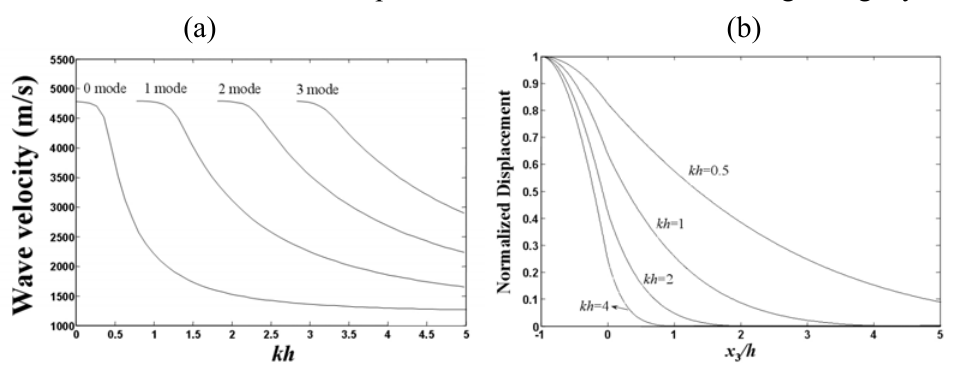
Figure 3. (a) phase velocity versus normalized waveguide layer thickness for first five -PMMA layered structure. (b) Love wave normalized modes in a 41 o -YX LiNbO 3 displacement u versus normalized depth x / h for different thickness of guiding 2 3